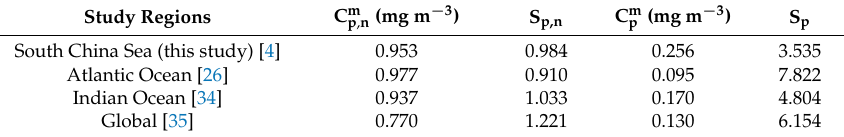
Table 2. Parameter values derived from fitting the three-component model to pigment data from the South China Sea. For comparison, parameter values from other oceans are also provided. C m p,n and C m p are the asymptotic maximum values for C p,n and C p , respectively. S p,n and S p are the initial